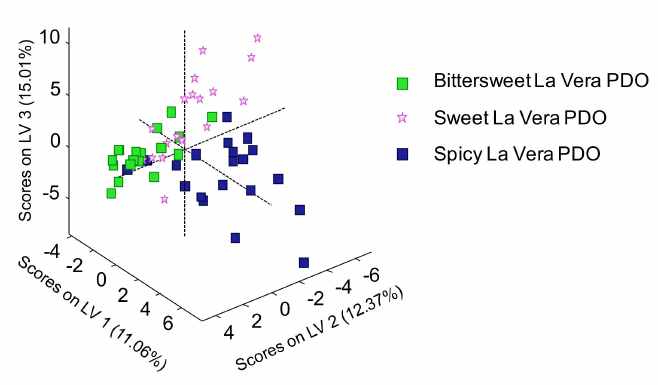
Figure 7. 3D plot of scores of PLS-DA (LV1 vs. LV2 vs. LV3) when the UHPLC-HRMS polyphenolic and capsaicinoid profiles were employed as chemical descriptors for the La Vera PDO sample classification, according to the flavor